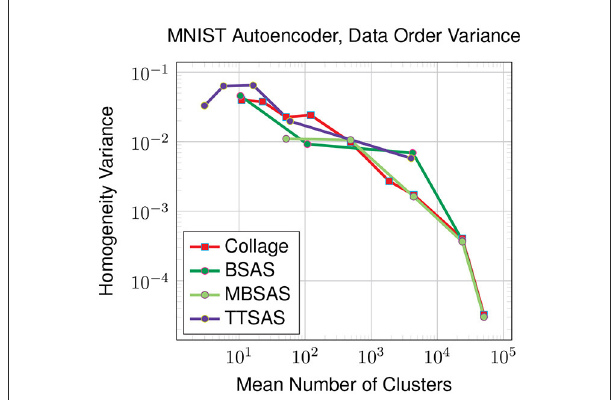
FIGURE10 Variance of homogeneity across 10 different data orderings. Latent representations generated for the MNIST dataset by the autoencoder model. For TTSAS, r 2 is 10% larger than r